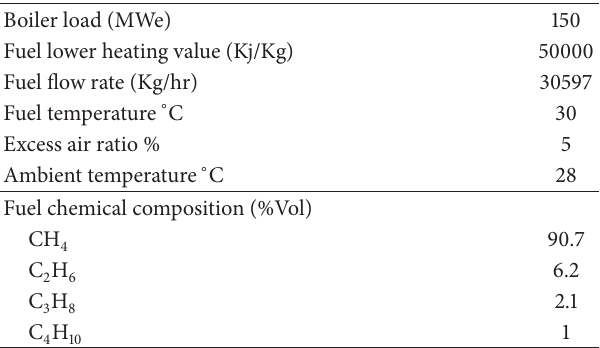
Figure 3: Total emissivity based on present calculations and Truelove’s models for gas combustion, 𝑃 𝑤 /𝑃 𝑐 = 2